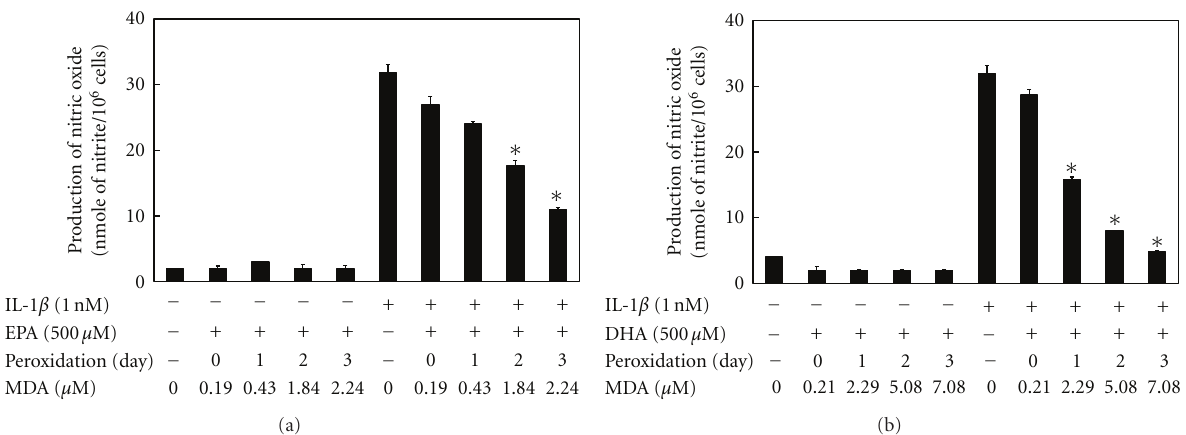
Figure 2: E ff ects of peroxidized EPA/DHA on the production of NO. Cultured hepatocytes were treated with IL-1 β (1nM) in the presence or absence of peroxidized EPA (a) and DHA (b) (each, 500 μ M) for 10h. The levels of nitrite were measured in the culture medium (data are means ± SD for n = 3 dishes/point; ∗ P < . 05 versus IL-1 β alone).